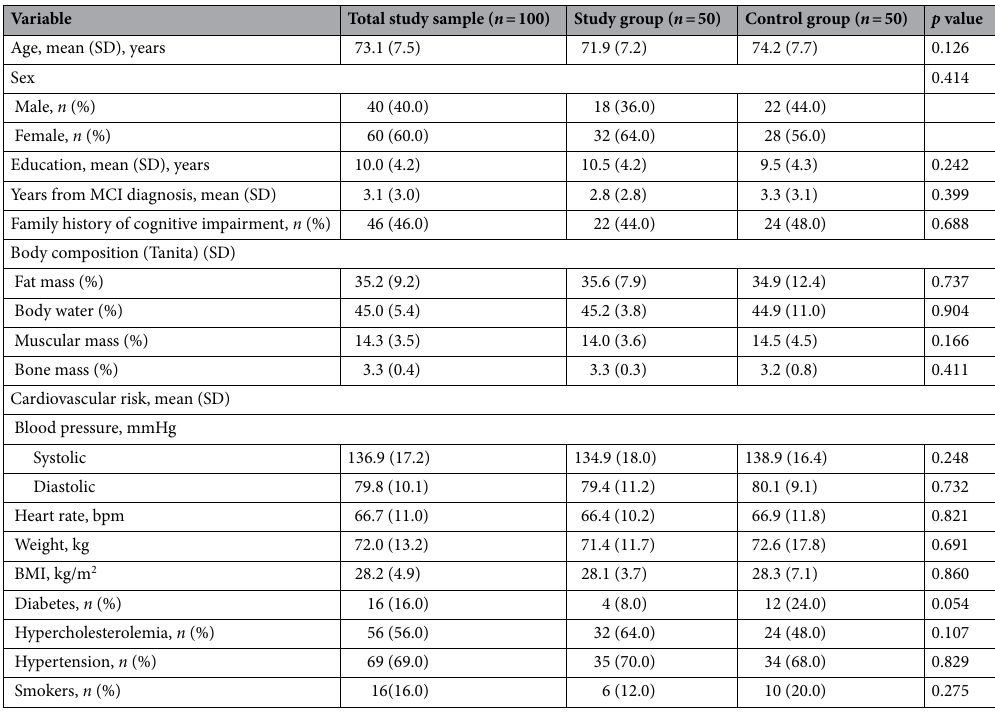
Table 2. Baseline demographic, Tanita, and cardiovascular characteristics of the study participants. SD standard deviation.